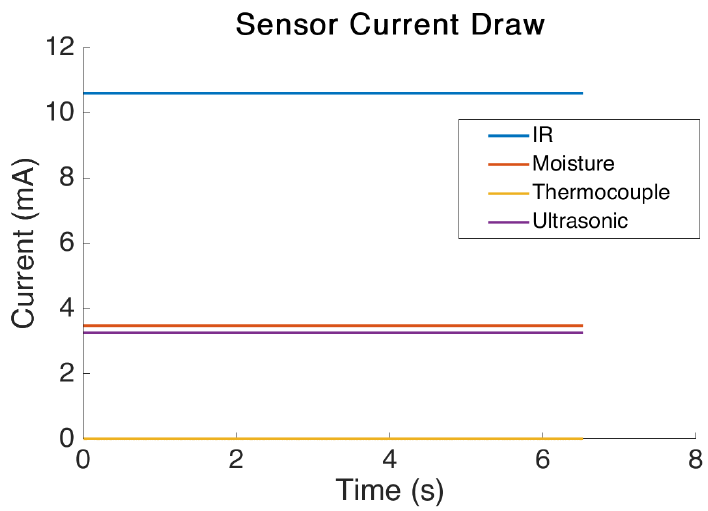
Figure 9. Sensor current draw test